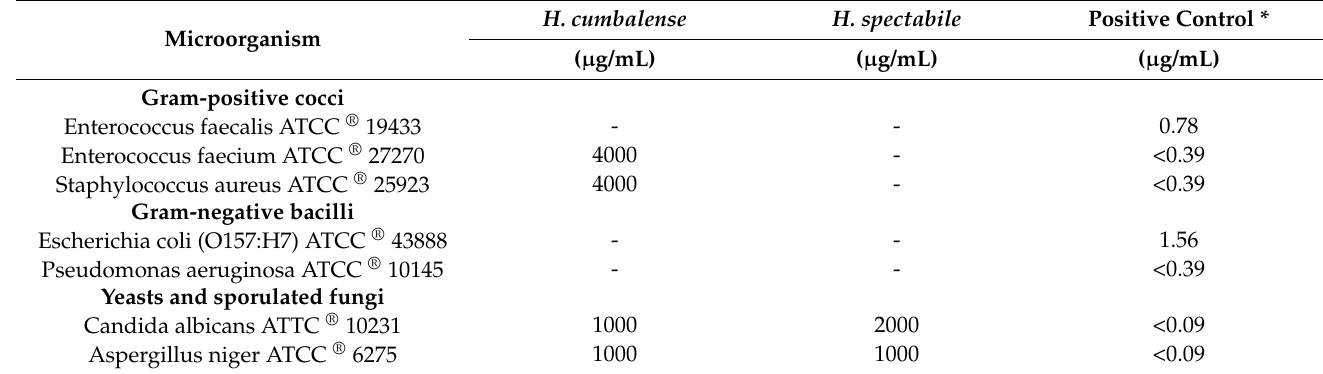
Table 4. The antibacterial capacity of essential oils of H. cumbalense and H. spectabile against pathogenic reference strains measured as the minimum inhibitory concentration (MIC) and expressed in µ